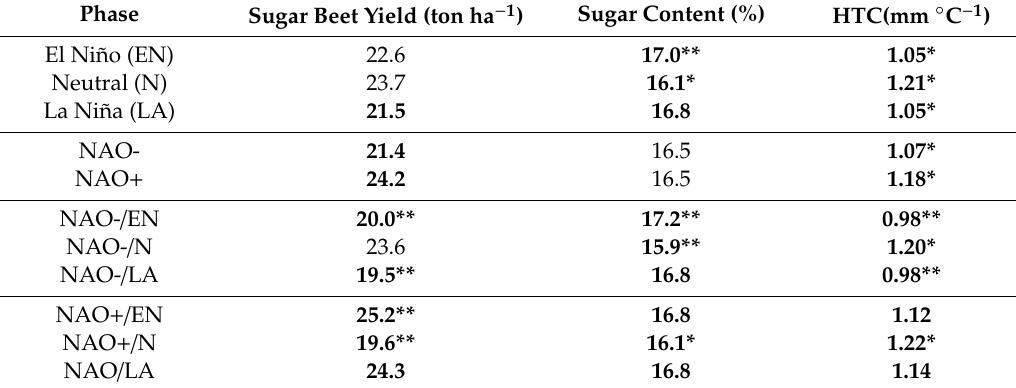
Table 1. Average sugar beet yield (tons ha − 1 ), sugar content (%), and HTC (mm ◦ C − 1 ) during di ff erent phases of El Niño and Southern Oscillation or the North Atlantic Oscillation. A bold (*, **) value indicates a mean di ff erent from the total sample at 90% (95%, 99%) confidence level as in